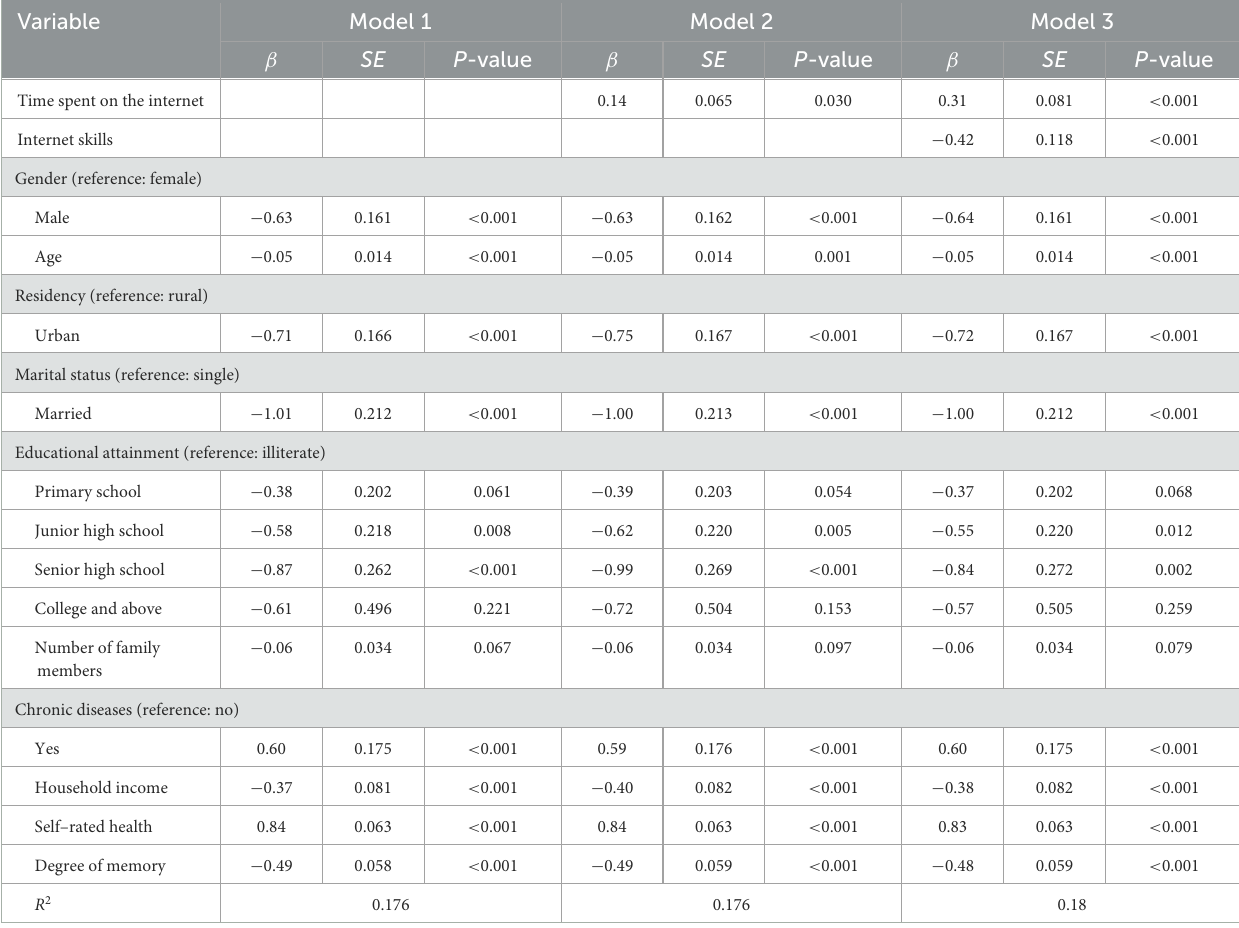
TABLE 3 Effect of time spent on the internet and internet skills on depressive symptoms.